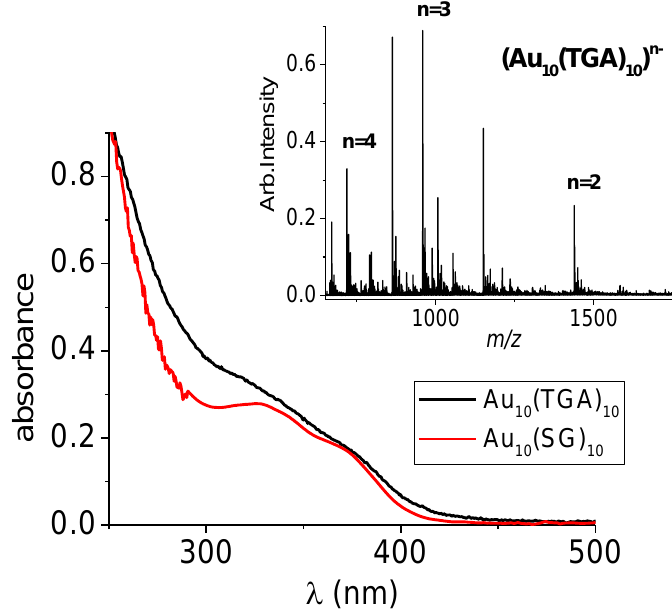
Figure 1. Experimental absorption spectra of Au 10 (SR) 10 nanoclusters (NCs) (with SR = thioglycolic acid (TGA)and SG (see [7]). (Inset) Electrospray ionization ESI mass spectrum of the as-synthesized Au 10 (TGA) 10 NCs.